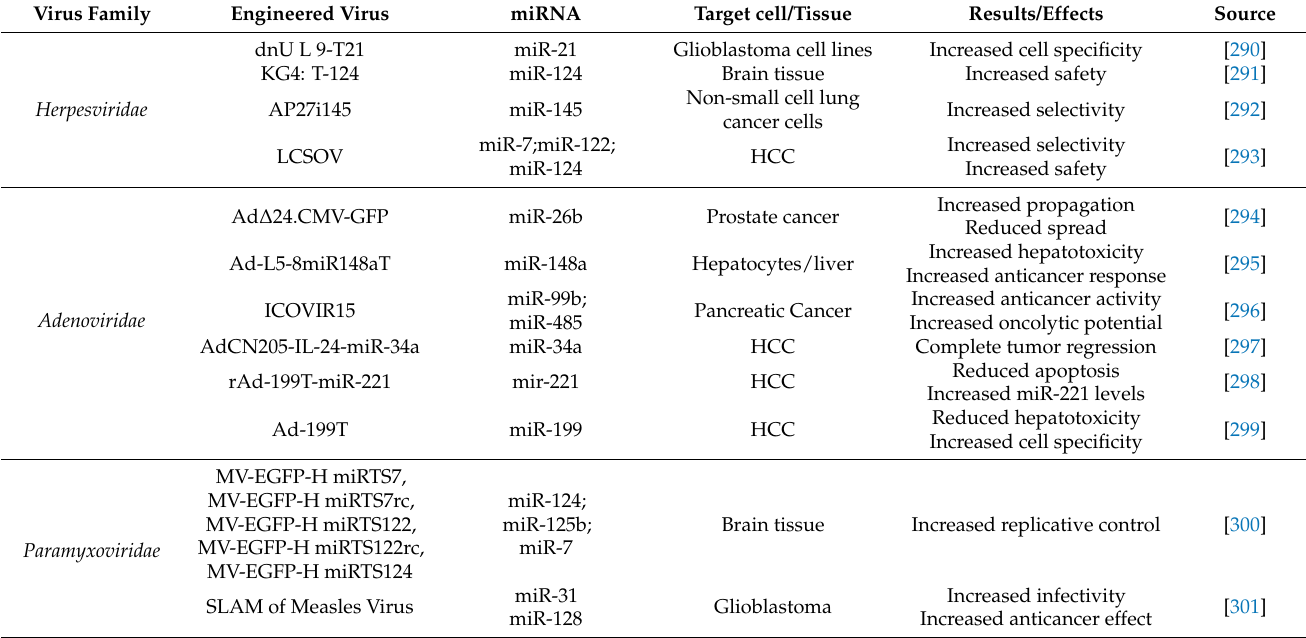
Table 3. miRNA-regulated vectors used in virotherapy. Engineered virus, tumor cells targeted by combinatorial treatment and the associated effects are